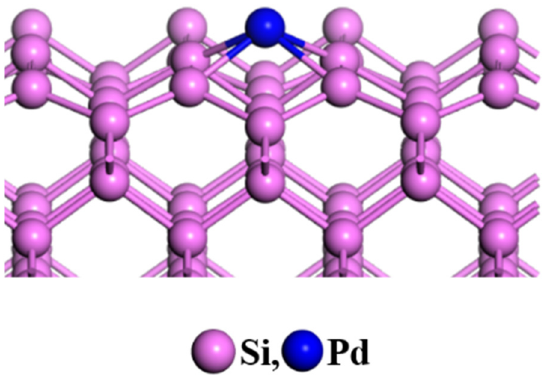
Figure 6. The obtained clean Si (100) with a Pd atom after geometry optimization. Excess ozone might have reacted with Pd* directly with an activation barrier of 0.64